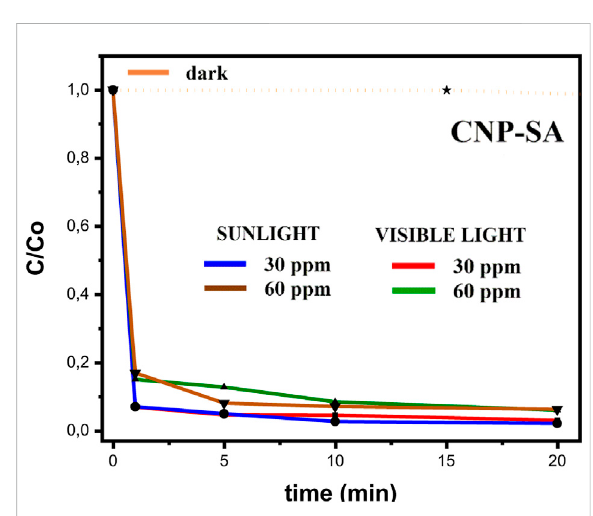
FIGURE 6 MBconcentration as a function ofirradiation time with visible light and sunlight with different concentrations of the dye using